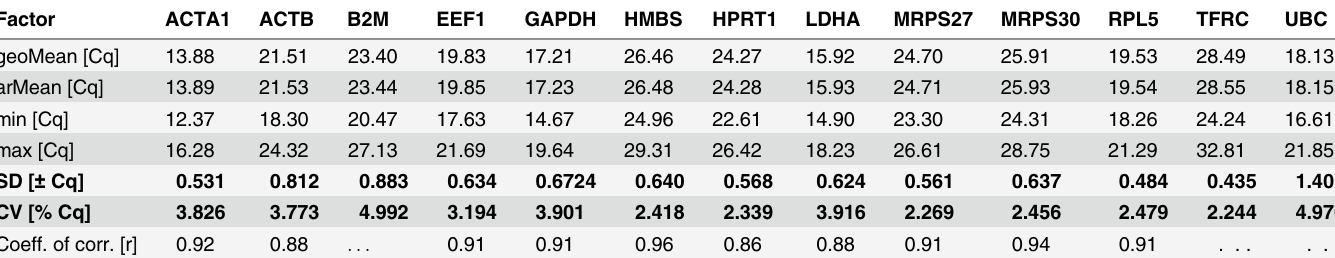
Table 2. Descriptive statistics and expression level of reference genes obtained by BestKeeper (n =